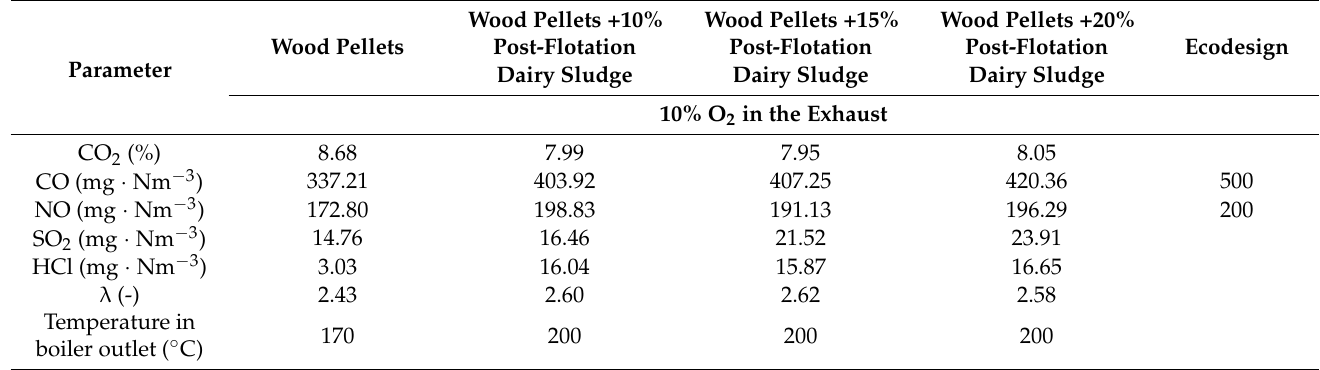
Table 6. Composition of exhaust gases from the combustion of pellets made of sawdust and pellets made of mixtures of wood sawdust with the addition of post-flotation dairy